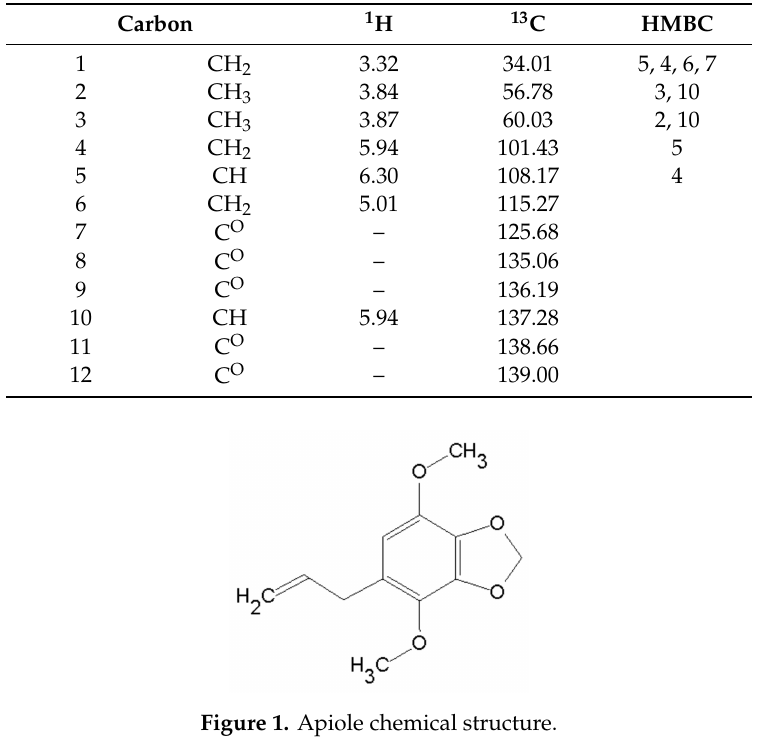
Table 1. H 1 and C 13 NMR spectral data for isolated compound (11 Tesla, CDCl3).